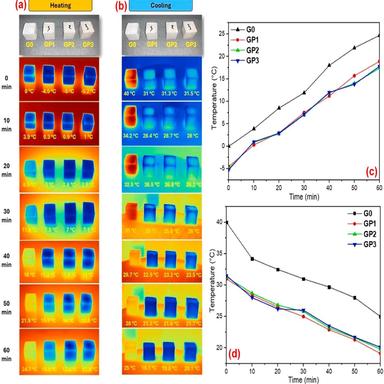
Thermal images: (a) Heating, (b) Cooling and (c-d) Temperature variations of Gypsum/PCM composites.